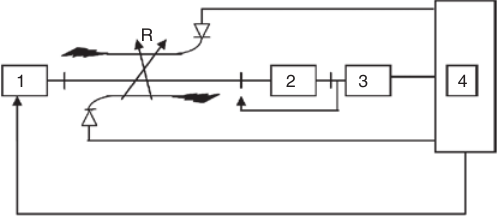
Figure 3: Scheme of the equipment for measuring the microwave properties. 1 – A set of generators for the whole range: HP686A and G4 – 79 to 82; 2 – coaxial section of the deck E2M Orion, with samples of material; 3 – power meter HP432A; 4 – scalar reflectance meter HP416A; R – reflect meter, including two directional couplers Narda 4222.16; two crystal detectors Narda